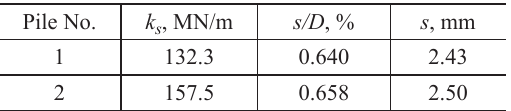
Table 5. Pile stiffness according to pile static tests and secant point on the Weibull curve Pile No.